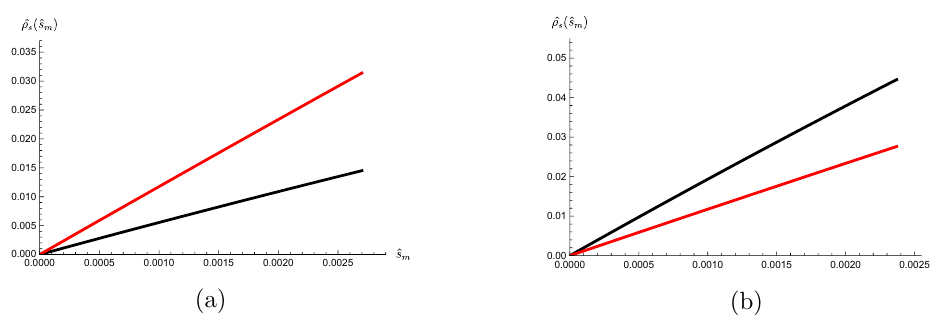
Figure 3. Dimensionless energy density ˆ ρ s as a function of ˆ s m . In both plots the black line corresponds to the blackfold solution of section 3, while the red to the (red) branch of the numerical solution of [12] which has a zero entropy limit. We plot the 2 solutions in the entropy regime that they co-exist. In (a) the blackfold energy density is depicted for the choice and is the preferable configuration in the constant entropy ensemble. In (b) the choice of parameters √ N 3 is such that = 70 and N 3 = 0 . 05 and the numerical solution N 5 N